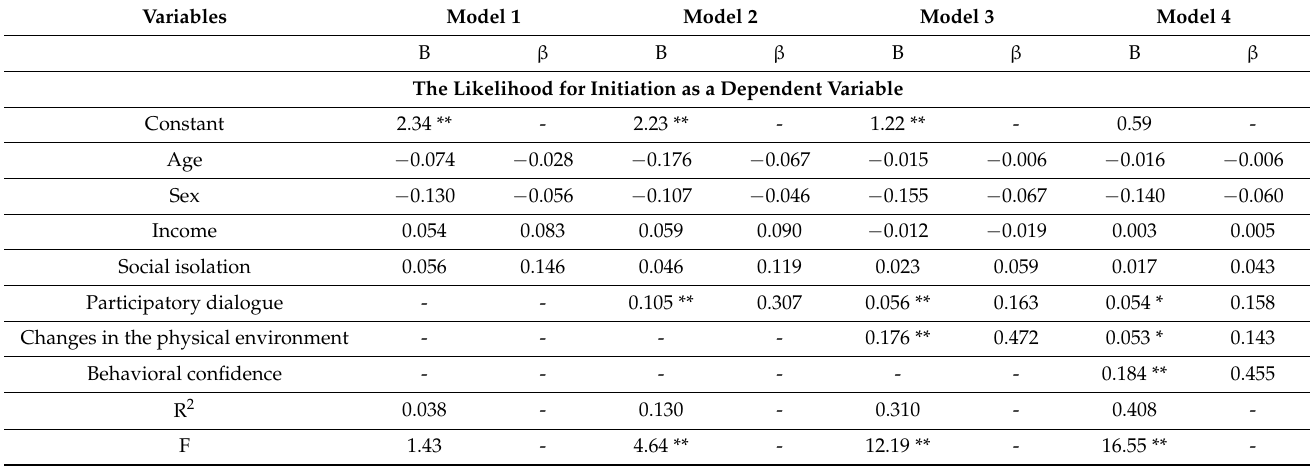
Table 4. Predicting likelihood for initiation and sustenance of technology users ( n = 227) through